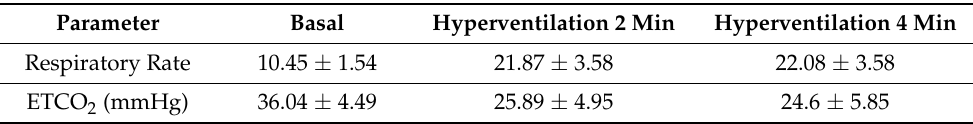
Table 1. Values of respiratory rate and end-tidal CO 2 during basal state and after 2 and 4 min of